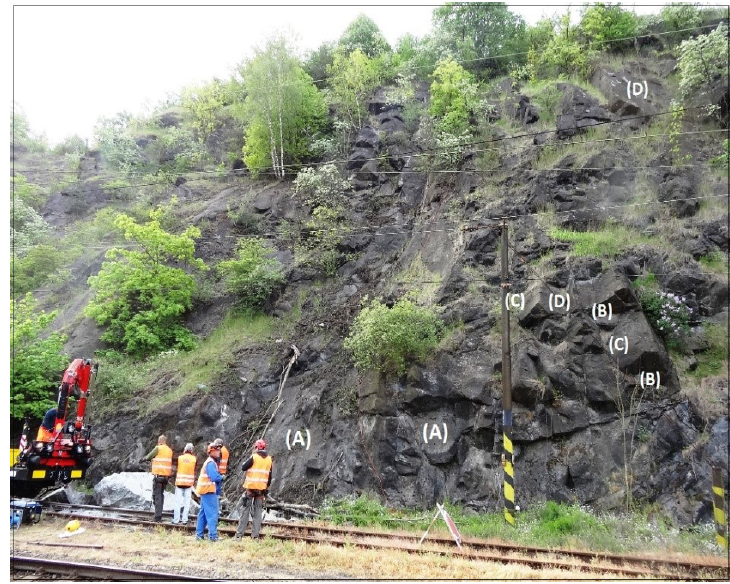
Figure 2. Discontinuity systems on the rock wall being